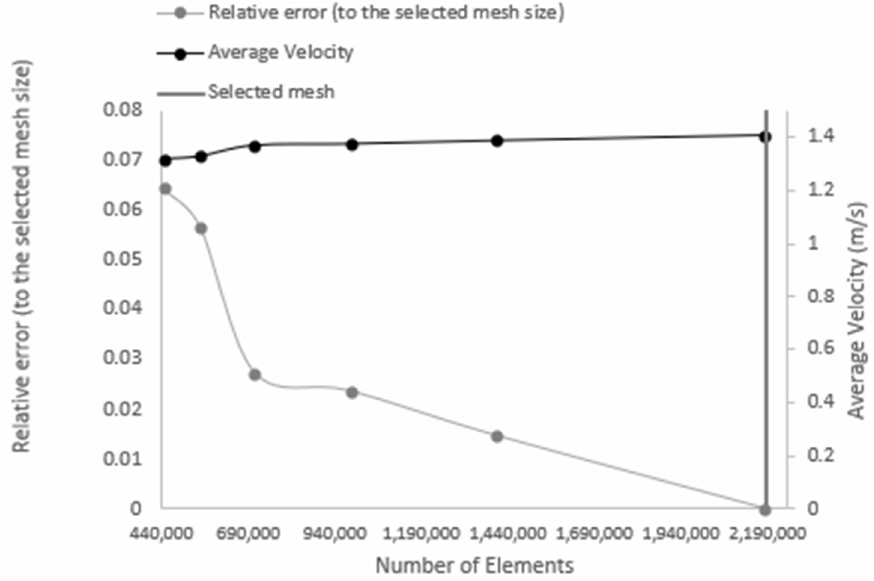
Figure 7. Mesh analysis—average velocity at 1.7 m offset (internal plane).